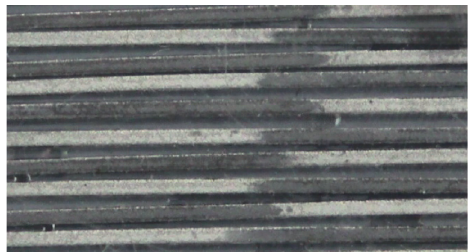
Figure 6: Image of the water accumulating in the specific flow channel at inlet gas temperature 45 °